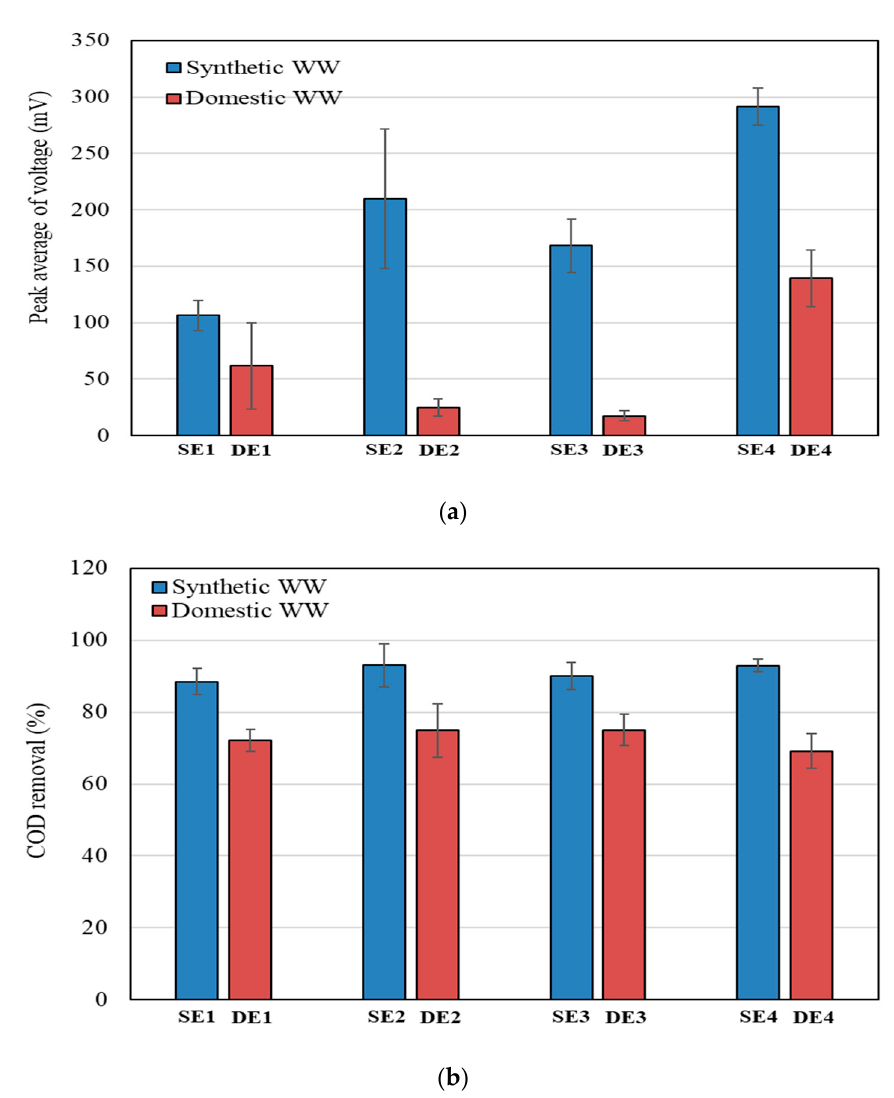
Figure 3. Peak average of voltage generation ( a ) and chemical oxygen demand (COD) removal ( b ) for 20 cycles of EBRs treating synthetic and domestic wastewaters (WWs) at phase 2 depending on initially anode potential.